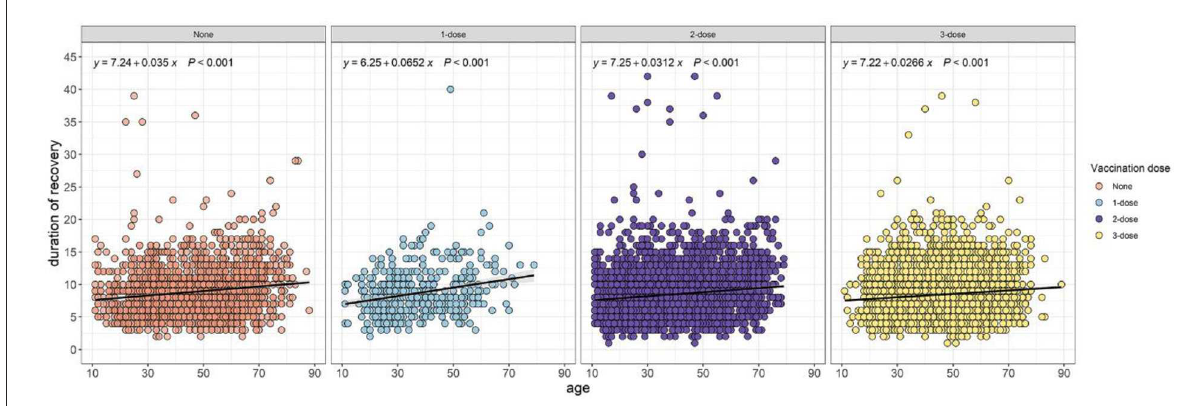
FIGURE2 Correlation between age and recovery duration assessed using Spearman correlation.